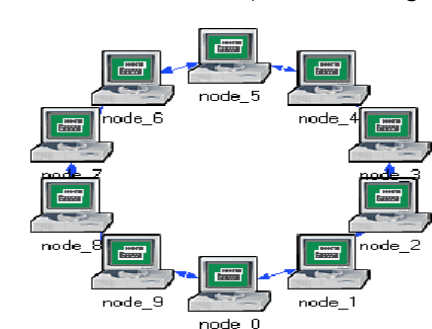
Fig.2 Topology of